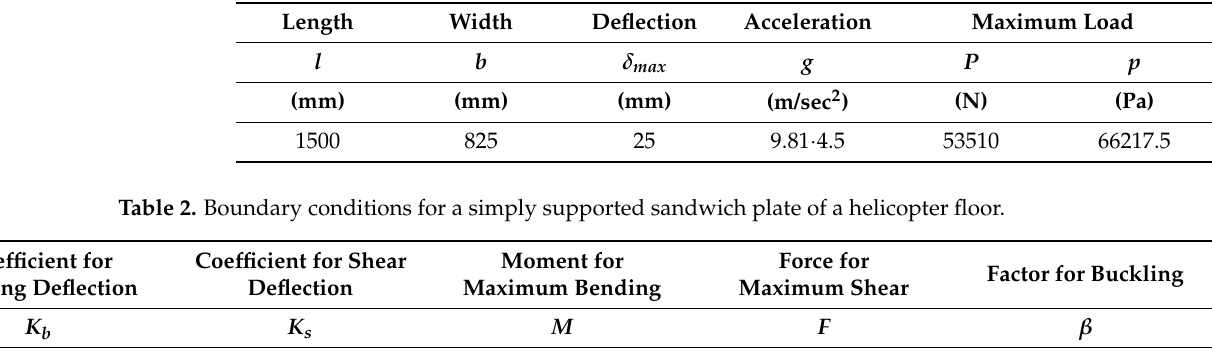
Table 1. Helicopter floor sandwich plate’s technical data [48].